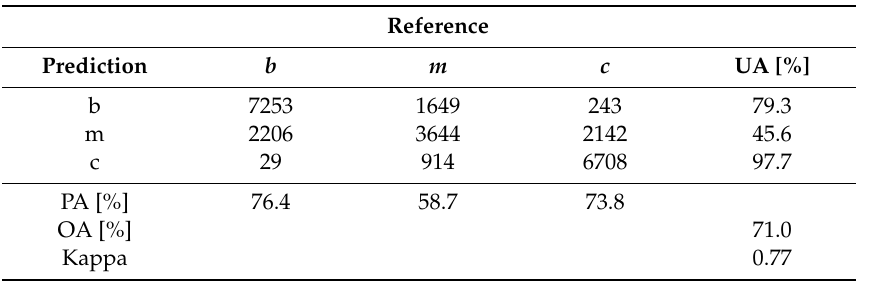
Table 3. Confusion matrix and accuracies for the whole area generated by validation based on reference inventory data. b = broadleaf, m = mixed forest, c = conifer, UA = user’s accuracy, PA = producer’s accuracy, OA = overall accuracy.